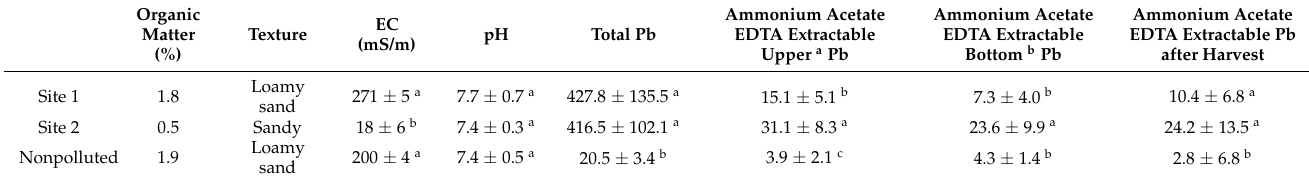
Table 1. Physicochemical properties, ammonium acetate EDTA extractable, and total lead (Pb) concentrations (mg kg − 1 ) of the experimental sites before cultivation and after the harvest.